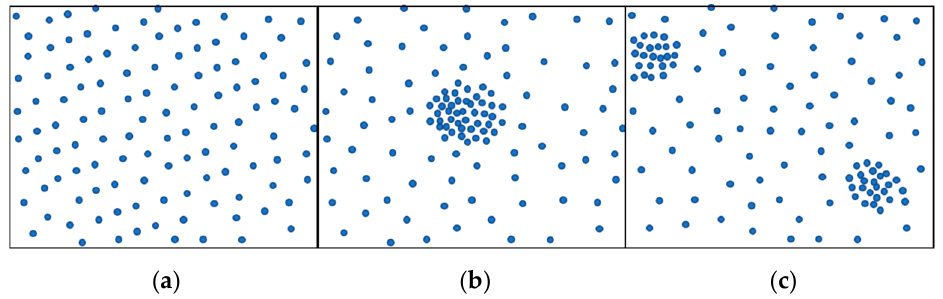
Figure 5. Type of disparity patterns ( a ) distributed, ( b ) centralized, and ( c ) clustered.